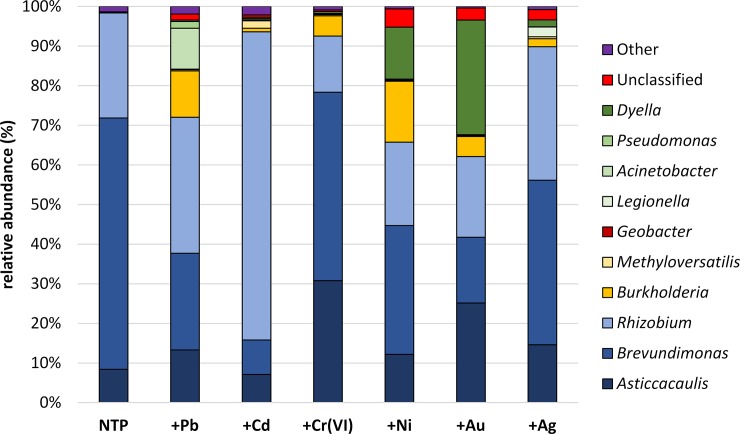
The main dominant genera of proteobacteria separated into α- (blue), β- (yellow), δ- (brown) and γ-classes (green).Violet color represents rare (<1%) 58 genera from all classes grouped together (S1–S4 Tables) and in red all unclassified microorganisms (22 families)–S5 Table.